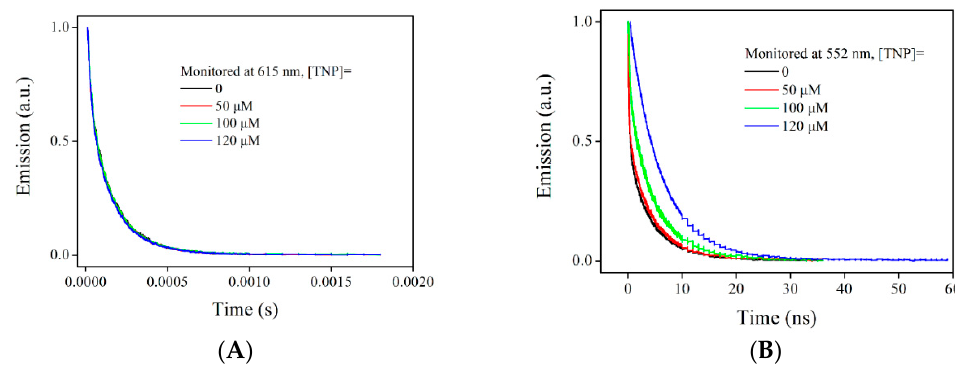
( B ) Figure 9. Absorption ( A ) and emission ( B ) spectra of RS6h@EuBTC suspension in ethanol (0.1 mg/mL)